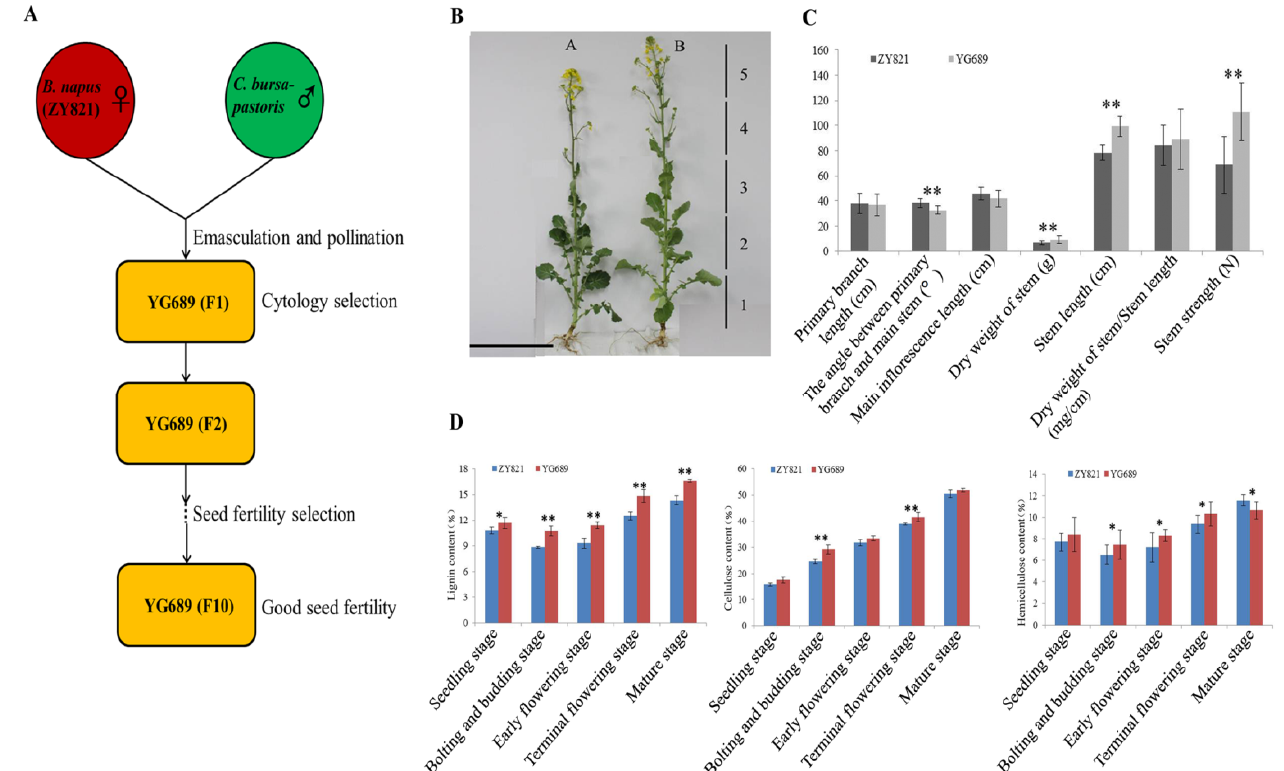
Figure 1. ( A ) The sketch map of YG689 generation from the hybridization of ZY821 and C. bursa-pastoris . ( B ) The morphology of ZY821 (Left) and YG689 (Right) at initial flowering stage. Bar = 50 cm. ( C ) The morphology analysis of ZY821 and YG689 at the mature stage (fifteen biological replicates). ( D ) Comparison of stem lignocellulose (lignin, cellulose, and hemicellulose) content of ZY821 and YG689 at five development stages (three biological replicates). * Significant at p < 0.05; ** significant at p < 0.01.